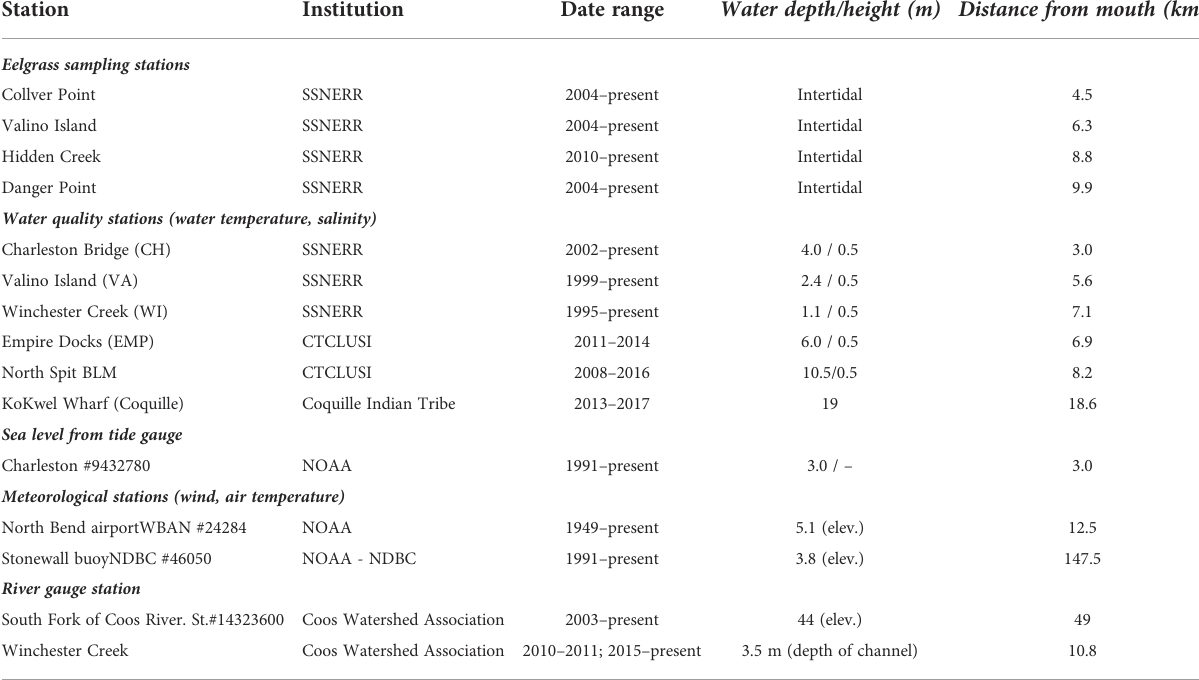
TABLE 1 Information on oceanographic and meteorological stations analyzed in this